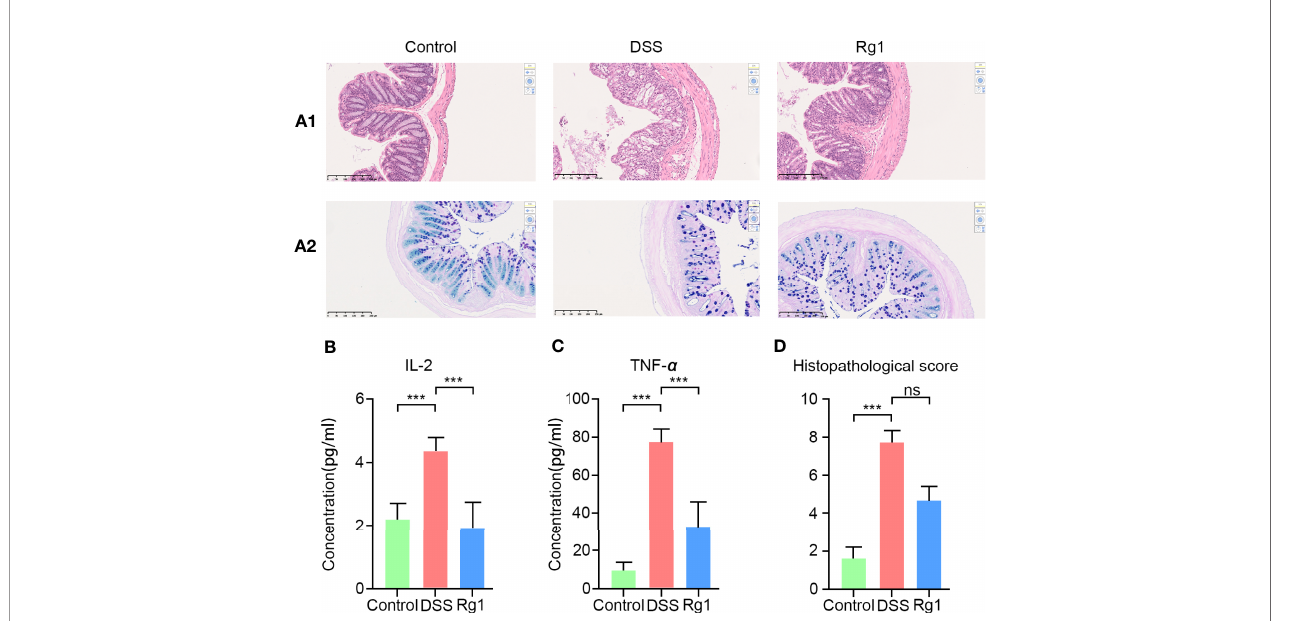
FIGURE 2 | The changes of colonic histopathology and in fl ammatory factors. (A-1) HE staining results in colon tissue. (A-2) AB-APS staining results of colon tissue. (B, C) The levels change of in fl ammatory factors including in colon tissues of each group, including IL-2 and TNF- a . (D) Histopathological score of three groups. P < 0.05 was considered to be statistically signi fi cant. Signi fi cance levels are indicated as ***P < 0.001 and ns stands for not statistically signi fi